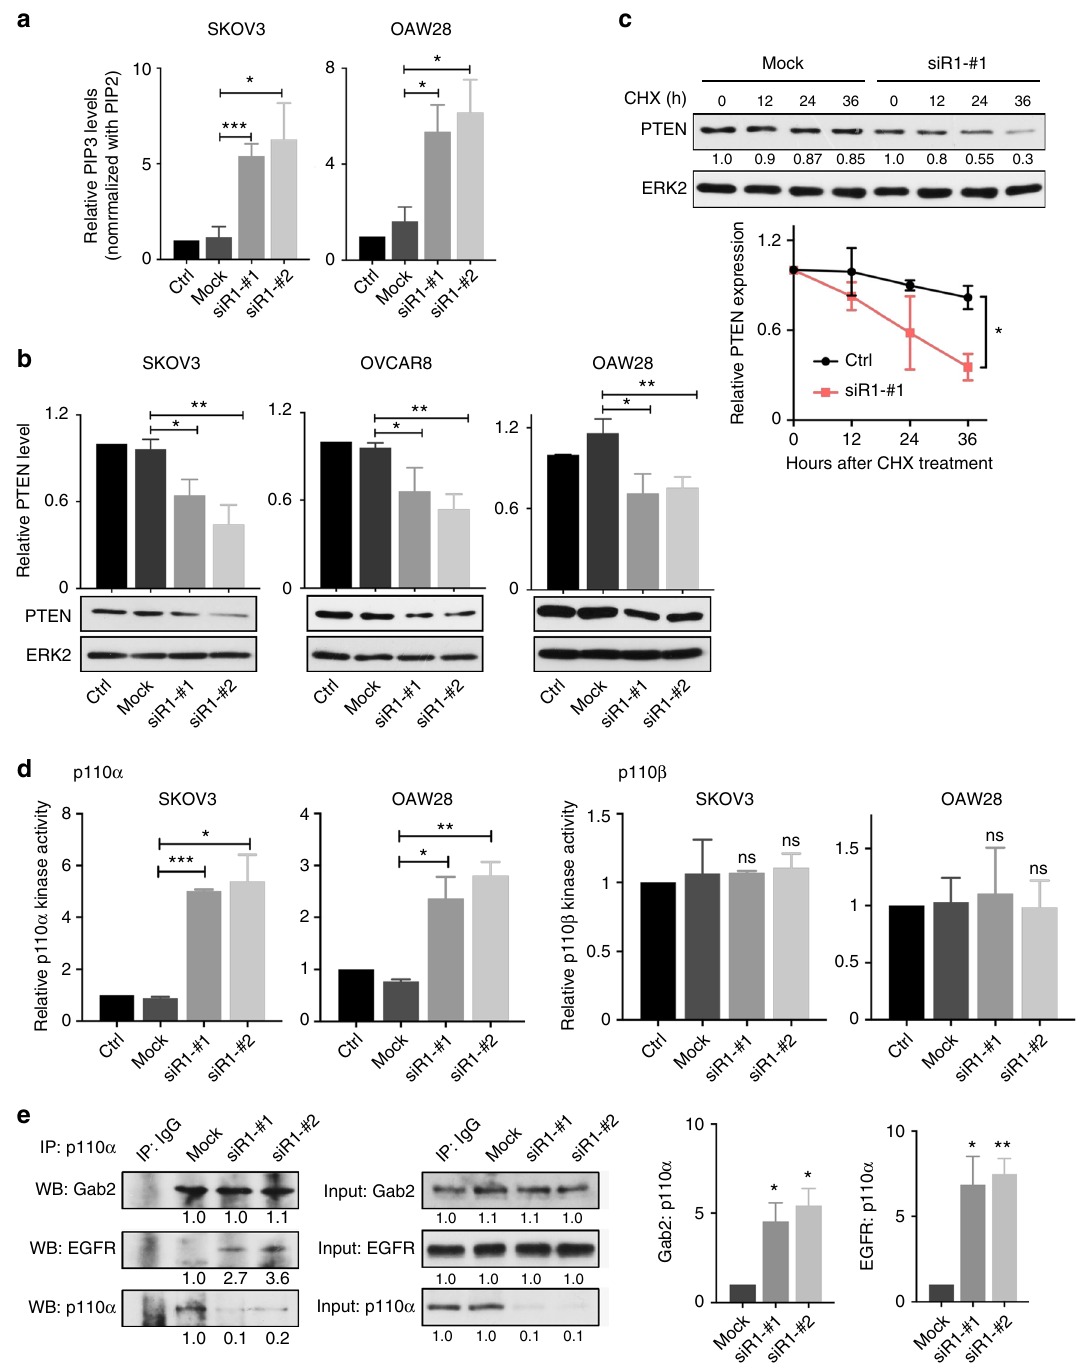
Fig. 5 PIK3R1 loss increases cellular PIP3 level by decreasing PTEN protein stability and enhancing p110 α activity. a Lipids of transfected SKOV3 and OAW28 cells were collected and subjected to lipid detection. PIP3 level in each sample was normalized to that of PIP2. b Protein lysates were subjected to western blotting. Band intensities of blots from three independent experiments were quanti fi ed and normalized to that of mock. Mean values of relative PTEN levels with SD are shown. c siRNA-transfected SKOV3 cells were incubated with 50 μ M Cycloheximide (CHX) for indicated hours before western blotting. Band intensities were normalized to 0 h time point and mean values with SD are shown. d p110 α and p110 β proteins were immunoprecipitated and subjected to PI3-kinase activity assay. Values were normalized to corresponding p110 α and p110 β protein levels. e p110 α protein was immunoprecipitated in OAW28 cells transfected with PIK3R1 siRNA prior to western blotting. The numbers below the blots represent the mean values from densitometry readings of three independent experiments. Error bars represent SD. * p < 0.05; ** p < 0.005; *** p < 0.001; ns, no signi fi cant difference compared with mock using t